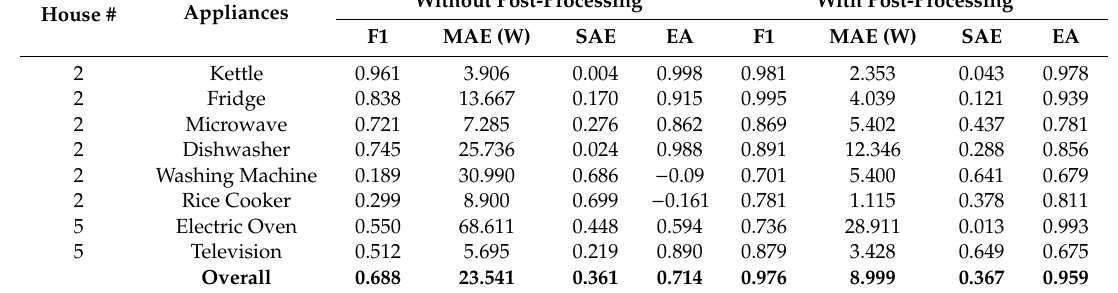
Table 3. Performance evaluation of the proposed algorithm in a seen scenario based on the ECO datasets.